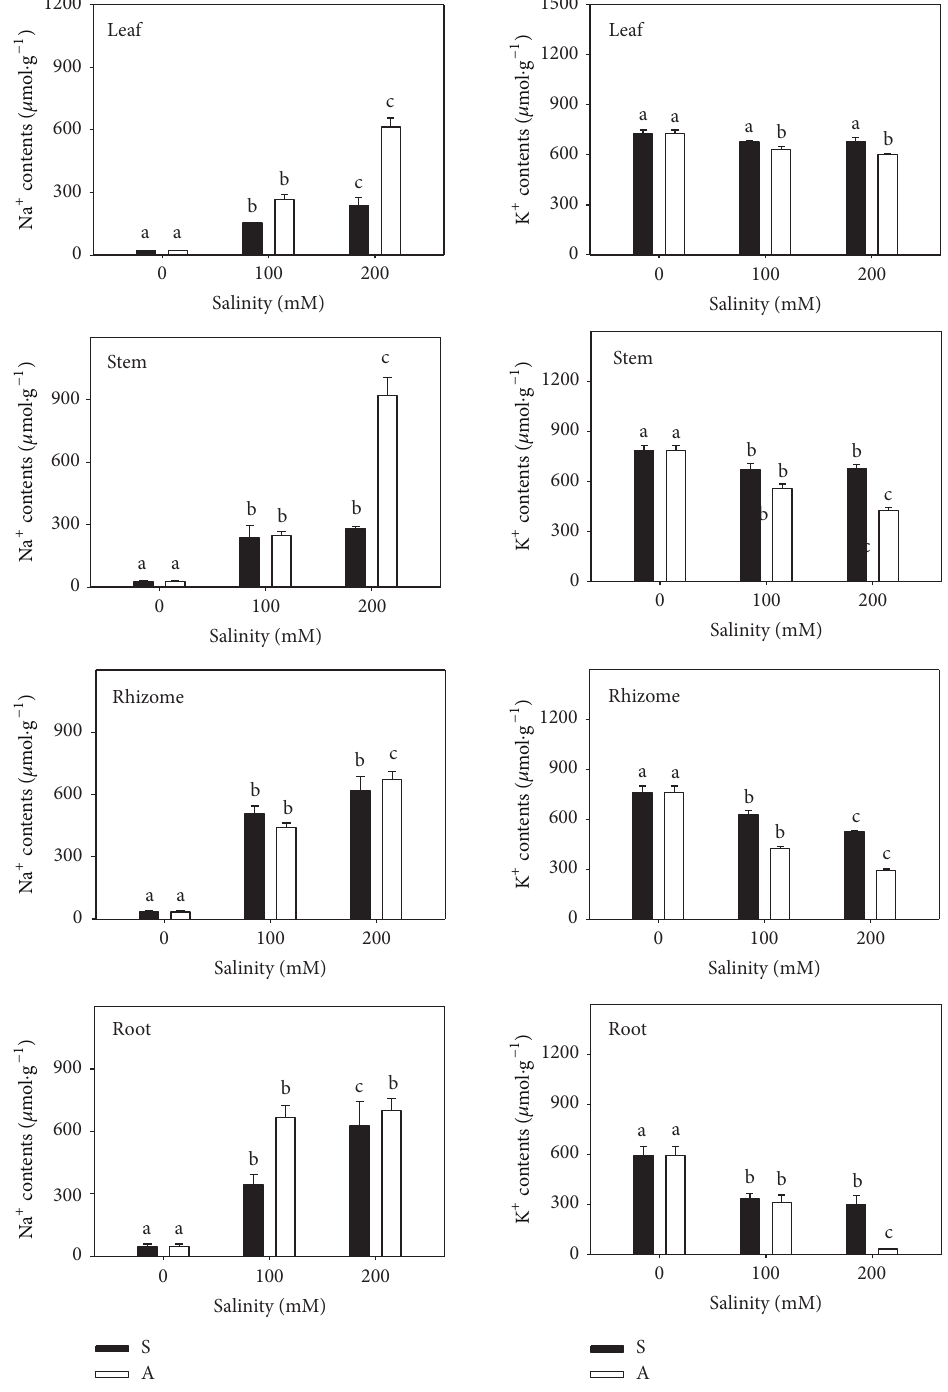
Figure 2: The Na + and K + contents. The effects of salt stress (S) and alkali stress (A) on Na + and K + contents in rhizomes, stems, roots, and leaves of L. chinensis . There are three levels under both stresses: 0, 100, and 200 mmol/L. The means and standard errors are reported. Within each column, the different letters indicate significant difference among treatments ( 𝑃 < 0.05